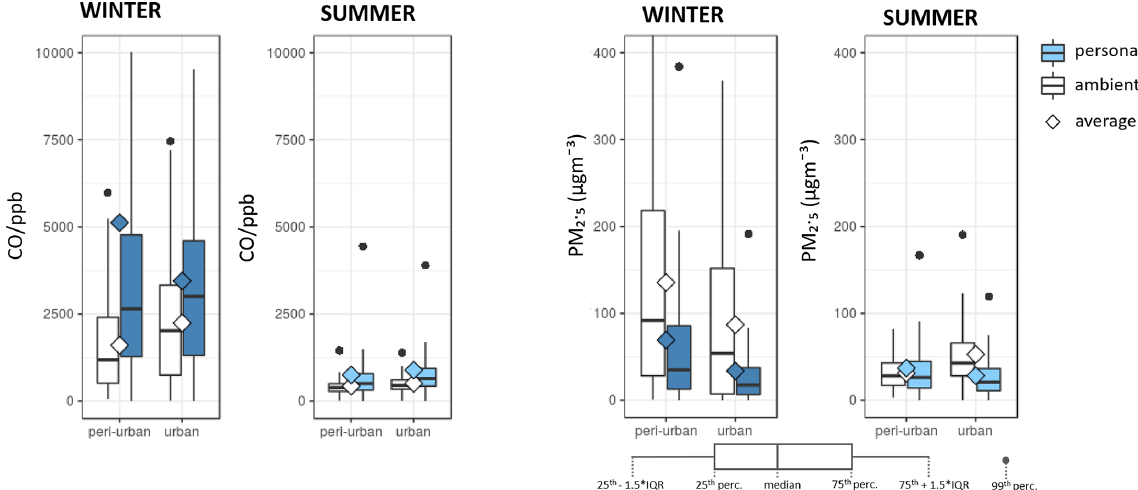
Figure 9. Box plots of ambient and personal air pollution levels in urban and peri-urban Beijing during the winter and summer campaigns. The white whisker box plots illustrate outdoor air pollution levels measured at the reference monitoring stations during the winter and summer campaigns. The blue box plots show the levels measured with 60 PAMs (dark and light blue for winter and summer respectively) deployed to 251 participants during the same periods. IQR: interquartile range; perc: